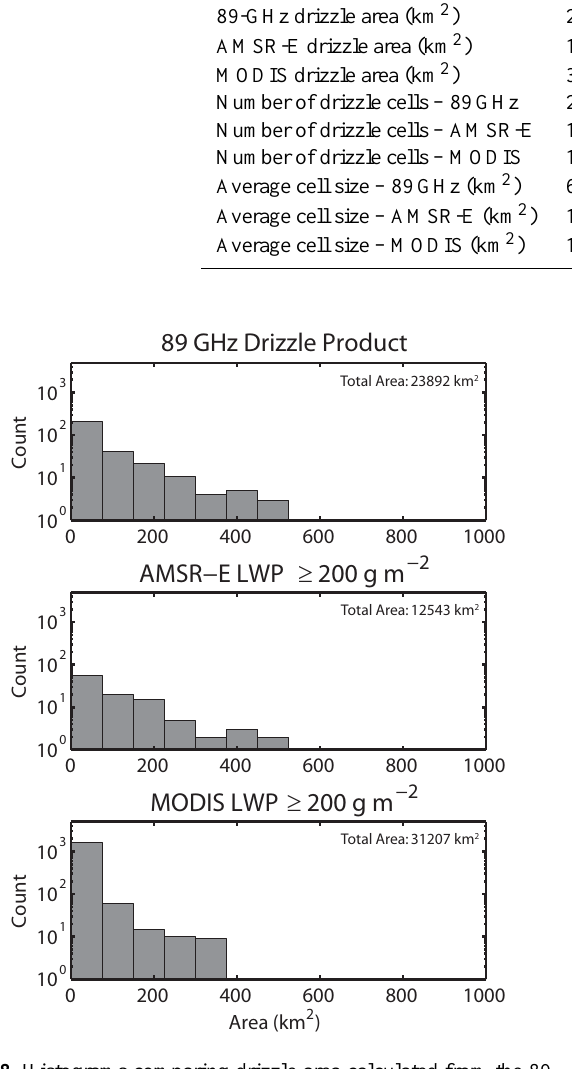
Fig. 8. Histograms comparing drizzle area calculated from the 89- GHz–based binary heavy drizzle classification product, AMSR- E LWP, and MODIS LWP for the time and region from Fig. 5. The upper panel is the area histogram for contiguous drizzle pock- ets detected using 89-GHz brightness temperature data. The middle panel is the area histogram for contiguous drizzle pockets defined as contiguous areas with AMSR-E LWP ≥ 200gm − 2 . The lower panel is the area histogram for contiguous drizzle pockets, defined as contiguous areas with MODIS LWP ≥ 200gm − 2 . The total area identified as drizzle is given for each product. Contiguous areas are identified based on